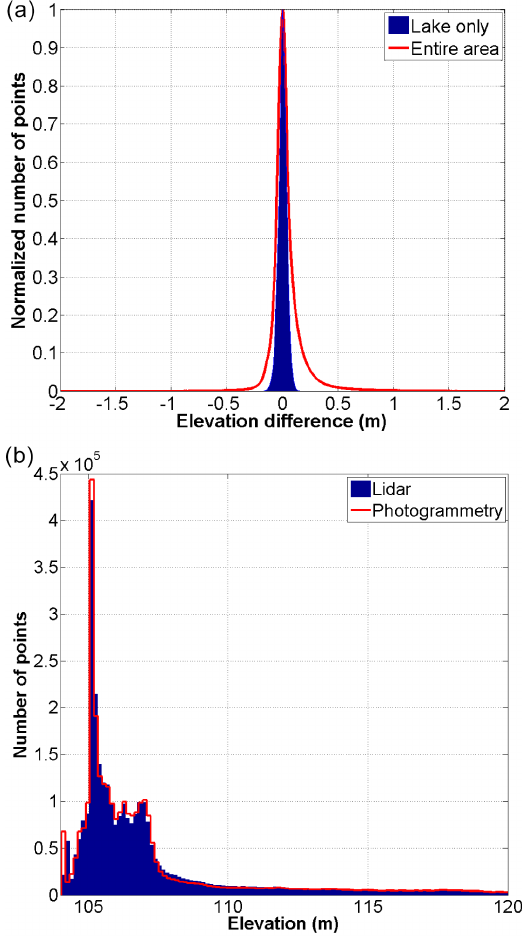
Figure 3. Assessment and validation of precision at Minto Flats. (a) Distributions of elevation differences between 6 and 8 Novem- ber DEMs to assess precision. The red curve is non-Gaussian with tails extending to ± 15m, caused by spatial aliasing of trees. The black curve is a better indication of system precision at ± 0 . 08m (95%). The histograms have been normalized by their maximum value and the means removed for comparison purposes. (b) The hypsometries of the reference DEM and validation lidar DEM are nearly identical